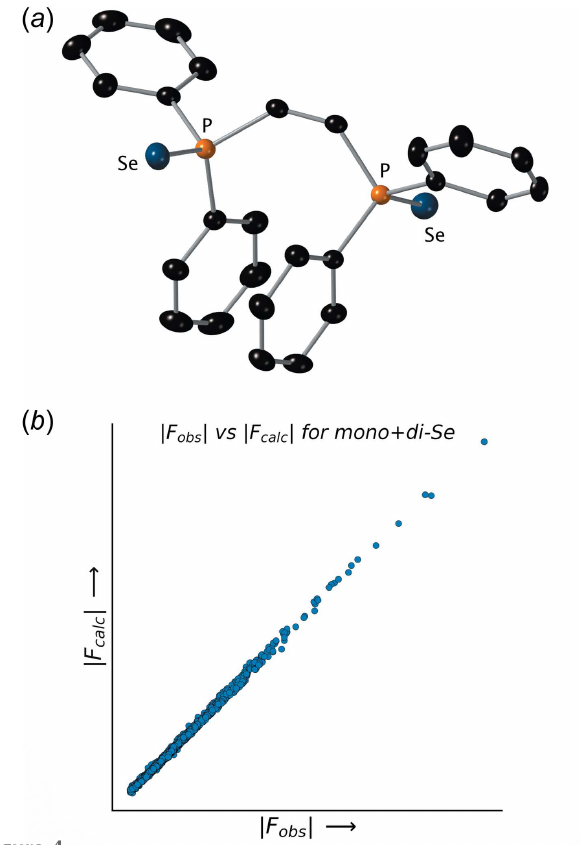
Figure 4 ( a ) An ellipsoid (50% probability) plot for the mixed mono-selenide/di- selenide model. Note that all ellipsoids appear quite normal. ( b ) A plot of | F obs | vs | F calc | values for the mixed mono-selenide/di-selenide model. Note the much reduced scatter in the plot relative to Figs. 2 and